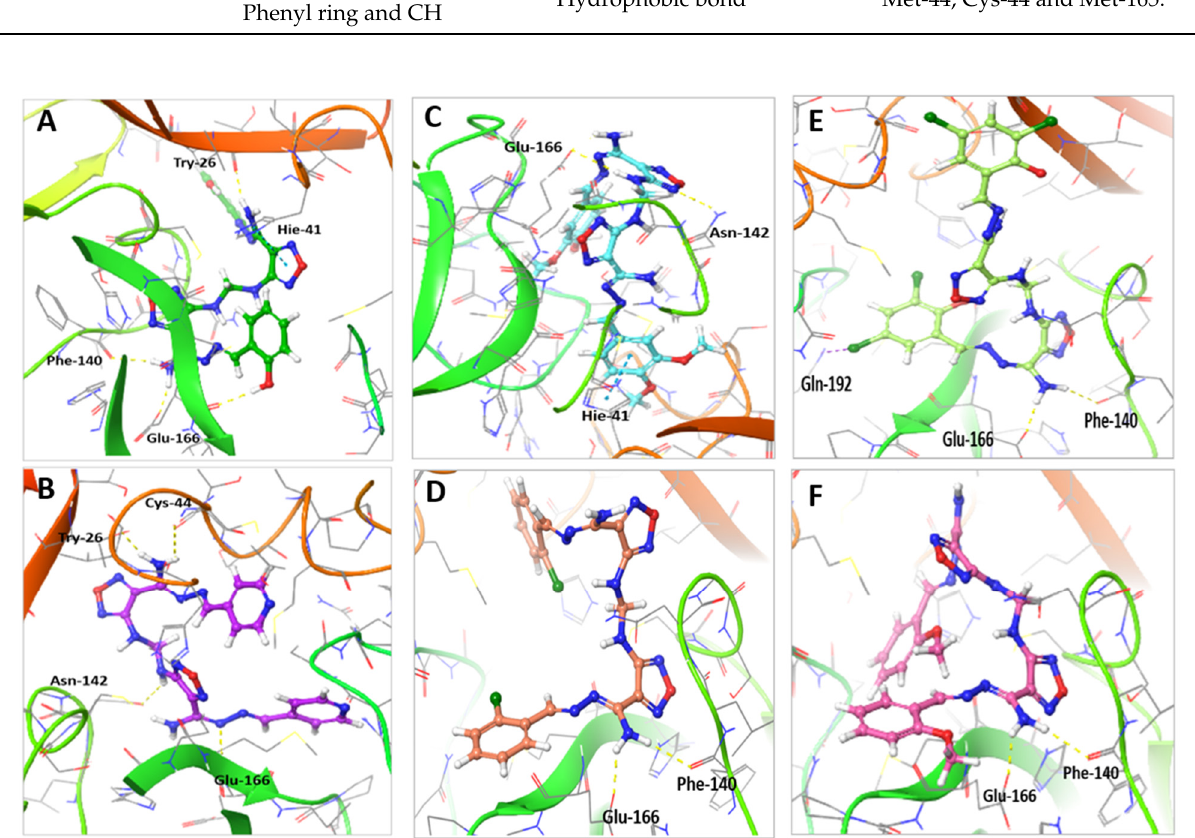
Figure 7. Molecular docking of compounds M1–5 compared to Compound 13 with SARS-CoV-2 M pro (PDB: 6LU7). ( A ) The interaction of Compound 13 (green stick) within the active site of M PRO . ( B ) The interaction of M3 (purple stick) within the active site of M pro . ( C ) The interaction of M1 (cyan stick) within the active site of M PRO . ( D ) The interaction of M2 (orange stick) within the active site of M pro . ( E ) The interaction of M4 (light green stick) within the active site of M pro . ( F ) The interaction of M5 (pink stick) within the active site of M pro . Table 2. Molecular modeling of the shortlisted compounds ( M1 – M5 ) within the binding active site of SARS-CoV-2 M pro when compared to Compound 13 .